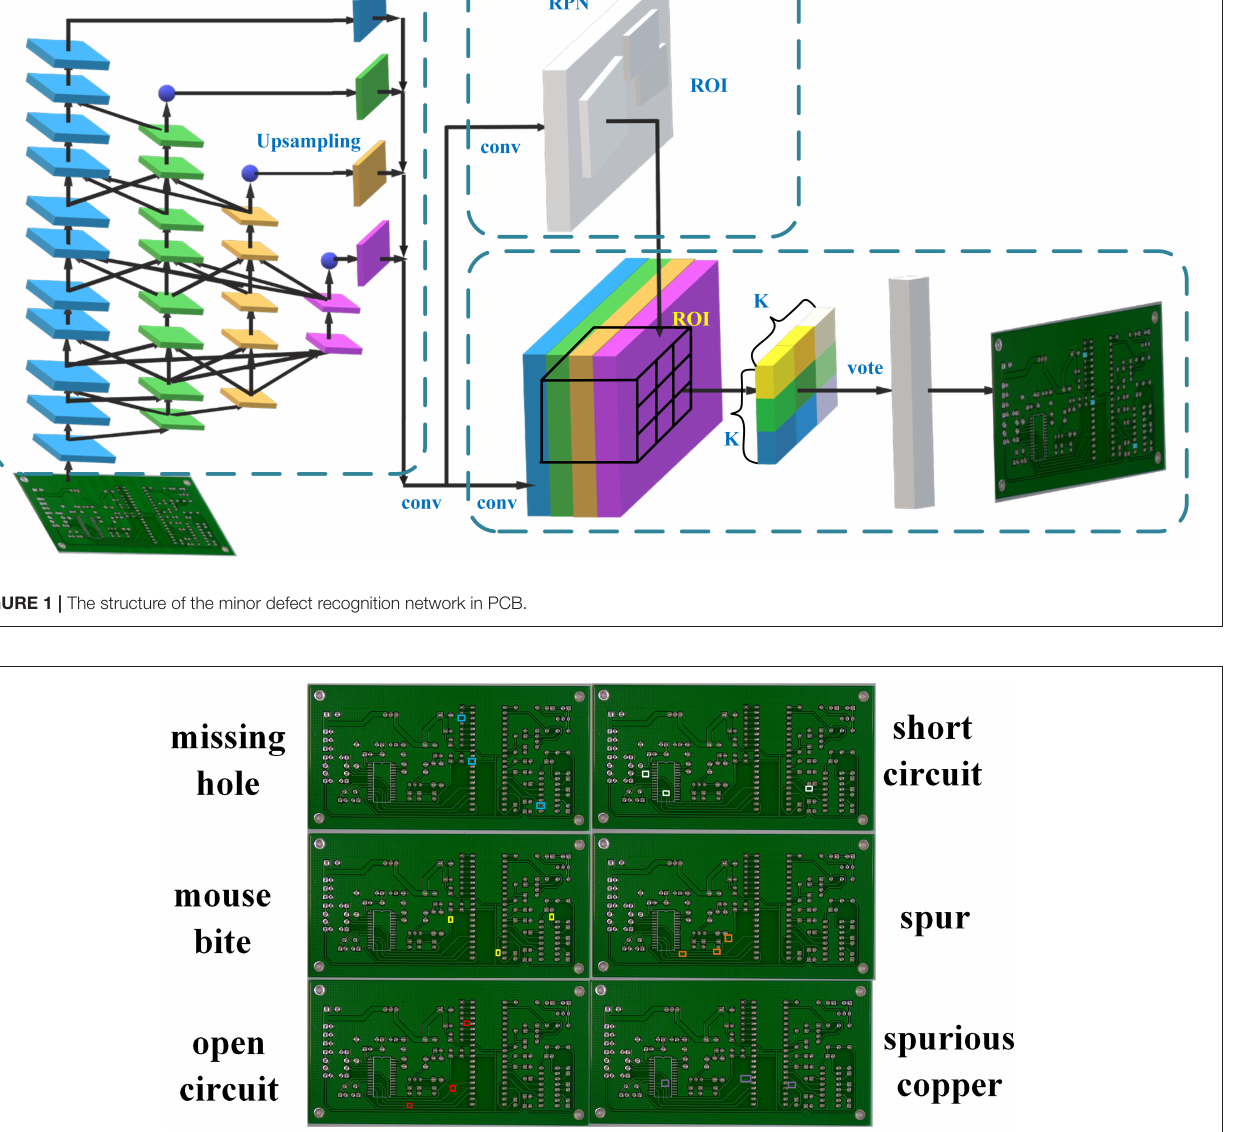
Where, f CCD means focal length of high-resolution camera, d PCB represents the distance between the camera and the PCB, H m represent the height of the imaging plane and H n means the field of view of the lens focal length